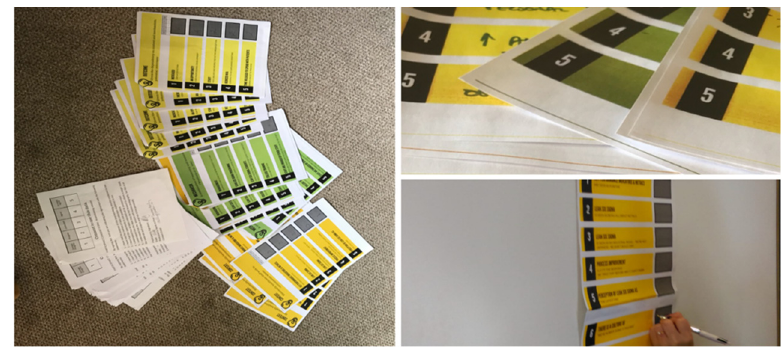
Figure 3. An example of our workbooks (source authors).